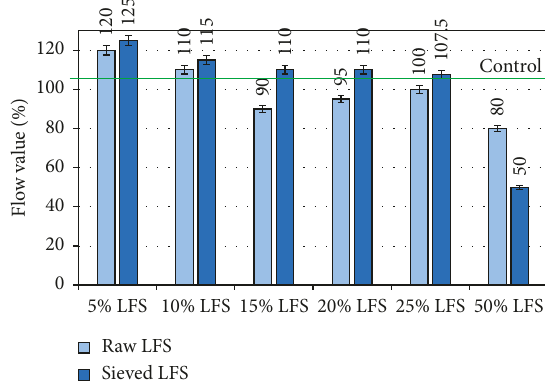
Figure 9: Flow value obtained for different LFS (raw and sieved) contents in